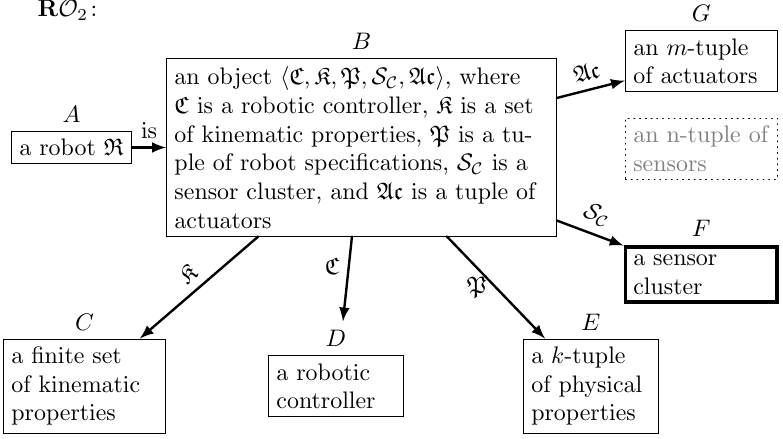
Figure 6. Illustration of olog revision on the example the robot-olog